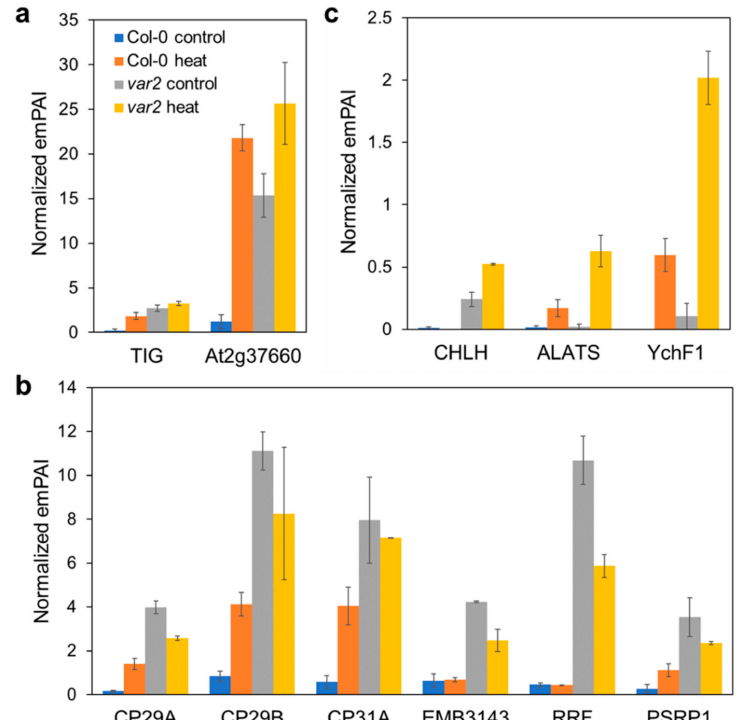
Figure 4. Altered stromal protein homeostasis in var2. The data represent emPAI-based normalized quantitative values (the mean of the two replicates +/ − SD). For detailed information, see Table S1. ( a ) Other aggregate-prone stroma proteins. TIG is chloroplast trigger factor. At2g37660 is an unknown protein. ( b ) Stromal proteins affected more by the FtsH loss than by heat stress alone. CP29A/B and CP31 are RNA-binding proteins. EMB3143 is also known as YCF54 or LCAA (Low Chlorophyll Accumulation A) and functions as a scaffold protein for a tetrapyrrole biosynthesis enzyme, magnesium protoporphyrin monomethylester cyclase complex. RRF is chloroplast ribosome recycling factor. PSRP1 (Plastid specific ribosomal protein) is not a ribosome subunit but a ribosome binding factor. ( c ) Heat-enhanced FtsH effects on the stromal protein abundances. CHLH is H subunit of magnesium chelatase involved in chlorophyll biosynthesis and is also known as GUN5 (genome uncoupled 5). ALATS is alanyl-tRNA synthetase. YchF1 is a GTPase.